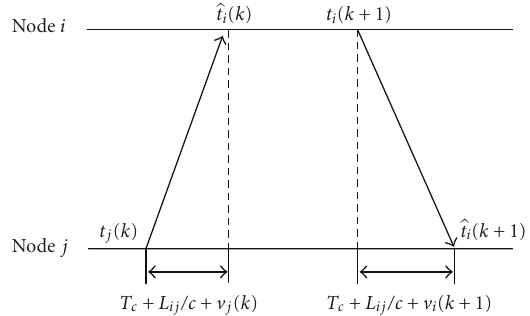
Figure 3: SO-DCTS algorithm with Gaussian delay during local time information